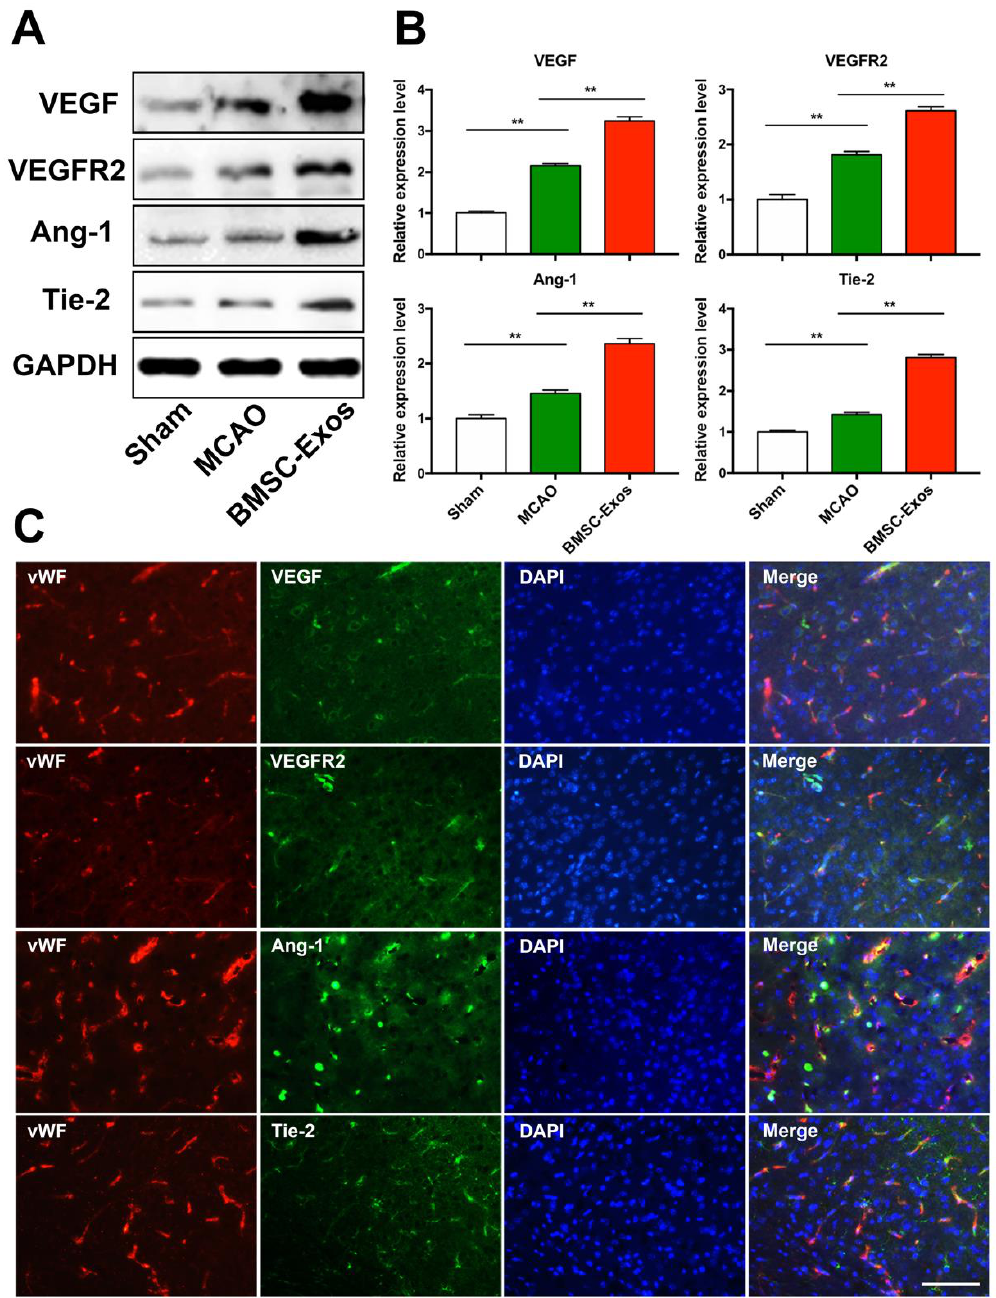
Figure 5. BMSC-Exos increased VEGF/VEGFR2 and Ang-1/Tie-2 protein expression after MCAO in mice. ( A , B ) Representative western blot analysis and quantification of densitometries of Western blot band. n = 3/group. ** p < 0.01. ( C ) Representative immunofluorescence images of the infarct boundary zone stained for vWF (red), VEGF/VEGFR2/Ang-1/Tie-2 (green), and DAPI (blue). Scale bar = 200 µ m. vWF, von Willebrand factor; BrdU, 5-bromo-2-deoxyuridine; DAPI, 4 ′ ,6-diamidino-2-phenylindole; BMSC-Exos, bone marrow mesenchymal stem cell-derived exosomes; MCAO, middle cerebral artery occlusion; VEGF, vascular endothelial growth factor; VEGFR2, vascular endothelial growth factor receptor 2; Ang-1, angiogenin-1; Tie-2, tyrosine kinase receptor-2; GAPDH, glyceraldehyde-3-phosphate dehydrogenase.